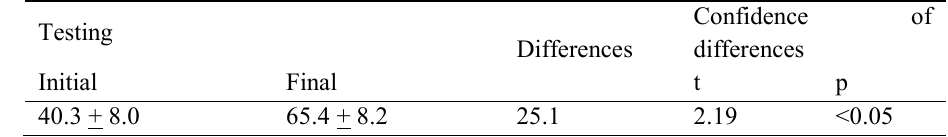
Table 3. Indicators of healthy life style skills’ level, conv. units (M + m) Testing